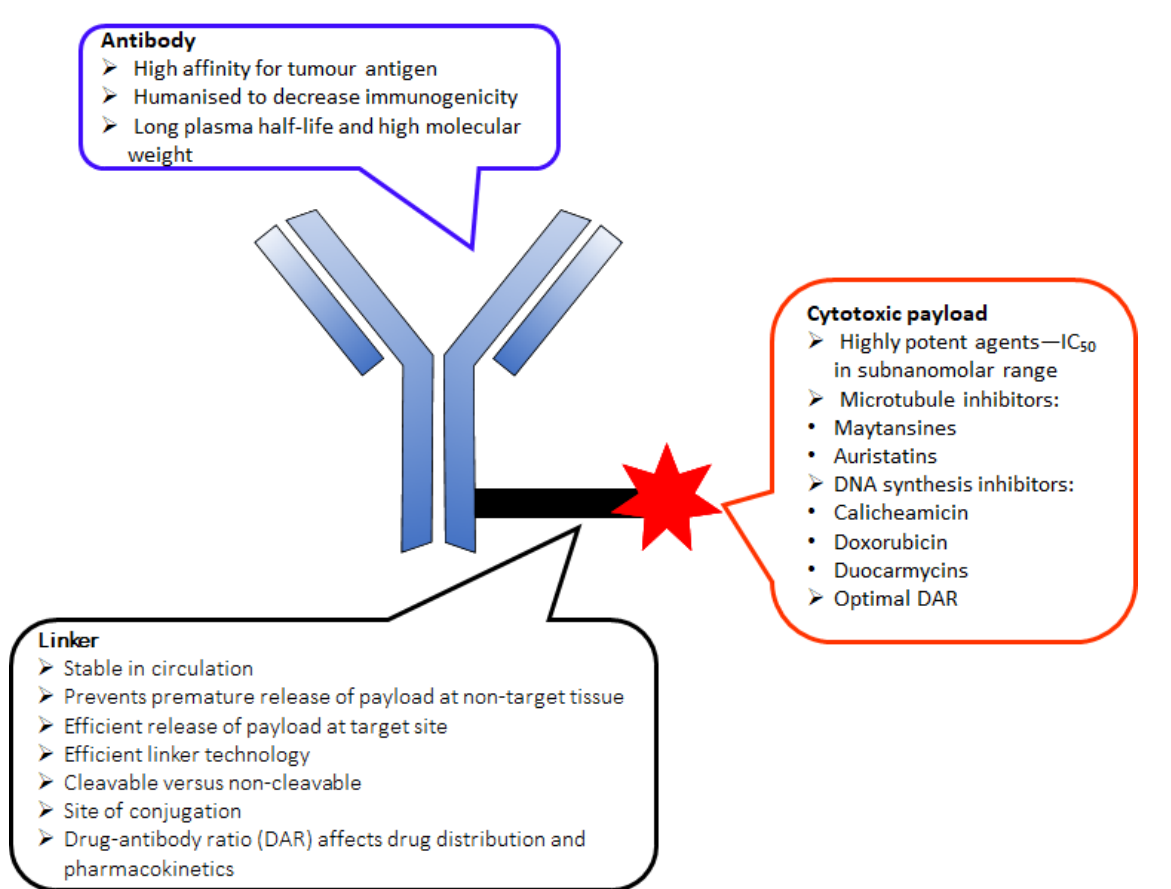
Figure 1. Schematic diagram of an antibody-drug conjugate (ADC).